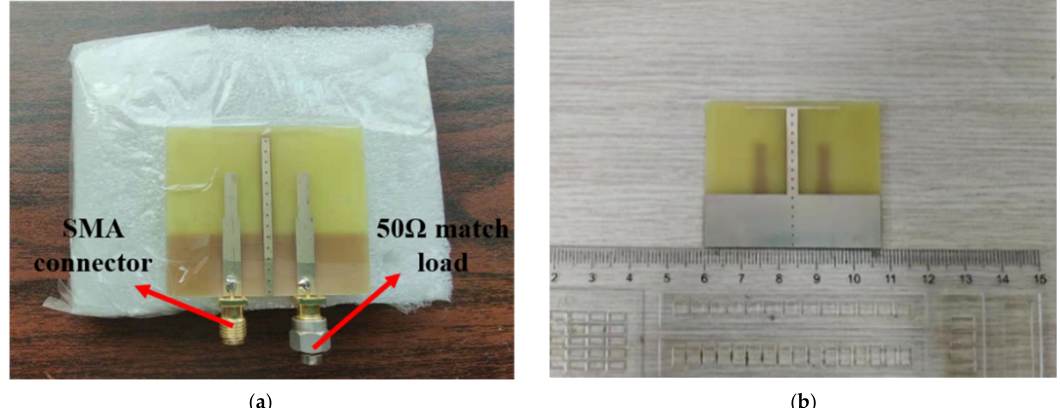
Figure 16. Photograph of the antenna prototype: ( a ) top view; ( b ) bottom view.